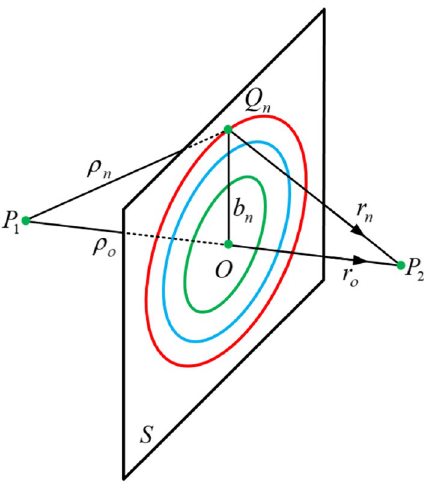
Figure 2. Fresnel zones